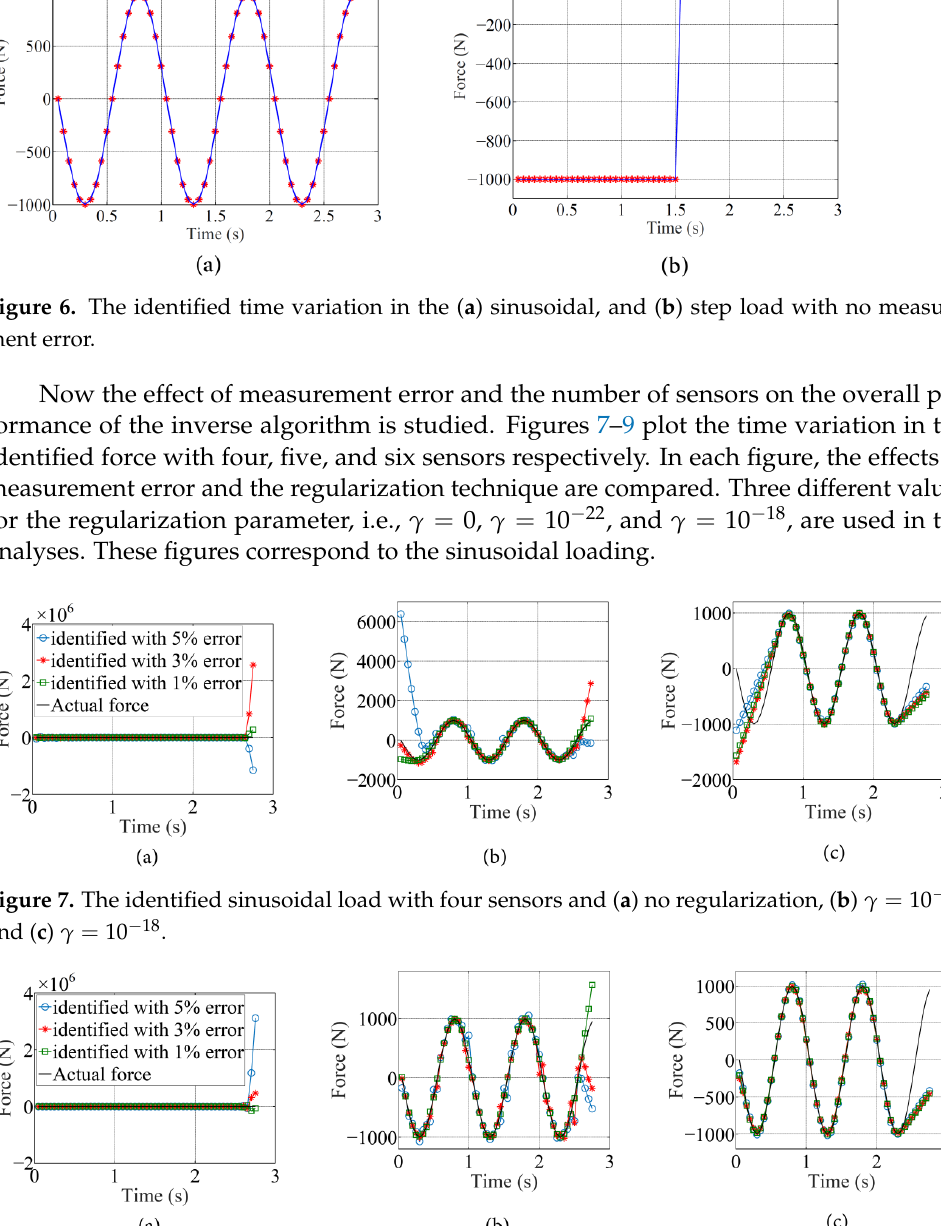
Figure 8. The identified sinusoidal load with 5 sensors and ( a ) no regularization, ( b ) γ = 10 − 22 , and ( c ) γ = 10 − 18 .